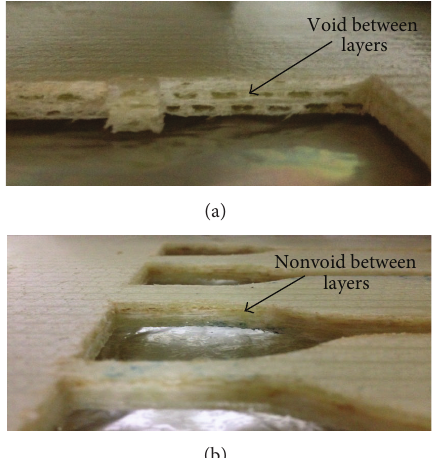
Figure 7: Water absorption for varying hybrid GFRP fibre arrange- ment.